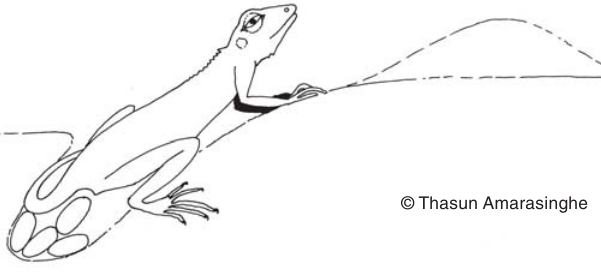
Figure 4. Egg laying of C. liocephalus .